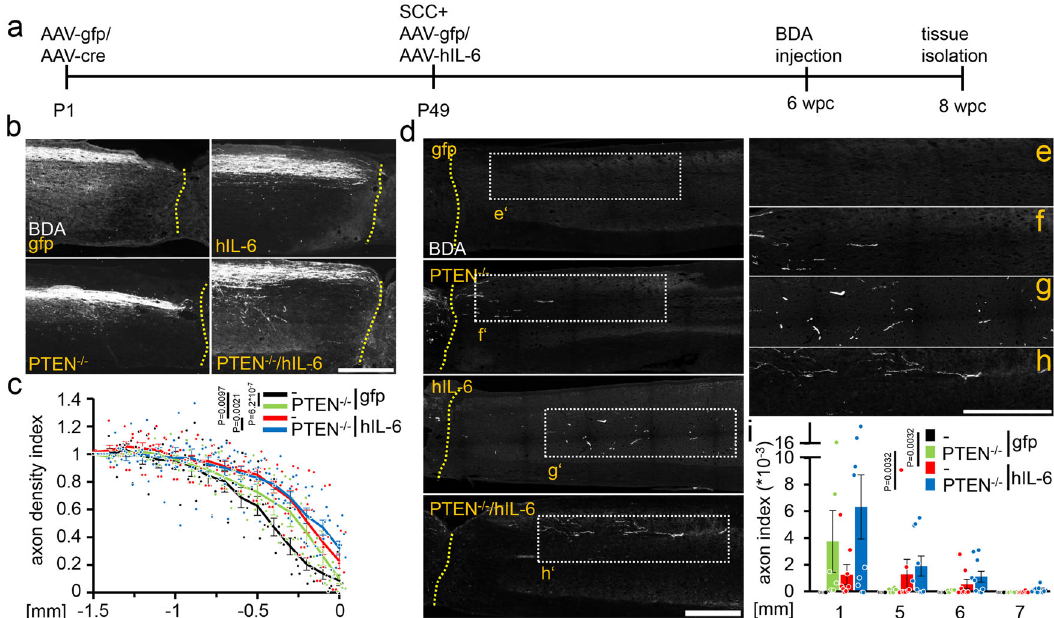
Fig. 2 Hyper-IL-6 promotes CST axon regeneration after severe spinal cord crush. a Timeline of surgical interventions for experiments presented in ( b – i ) and Figs. 3, 4. PTEN f/f mice received unilateral injections of AAV2-GFP (PTEN + / + ) or AAV2-Cre (PTEN − / − ) at P1. After 7 weeks, PTEN + / + and PTEN − / − mice were then subjected to spinal cord crush (SCC) (T8) and subsequently received additional unilateral intracortical injections of either AAV2-hIL-6 (hIL-6) or AAV2-GFP (gfp). b Sagittal thoracic spinal cord sections of four differently treated groups showing BDA-labeled, retracting axons (white) of the right main CST rostral to the lesion site (dotted line). Tissues were isolated 8 weeks after the SCC. Scale bar: 500 µ m. c Axon density index of CST fi bers analyzing all spinal cord sections with the main CST of the animals described in ( a , b ). Values at distances from 1.5 mm rostral to the lesion site ( − 1.5) up to the proximal lesion border (0) were determined. Values represent means ± SEM of 6 – 10 animals per group (PTEN + / + /gfp, n = 7; PTEN + / + /hIL-6, n = 9; PTEN − / − /gfp, n = 6; PTEN − / − /hIL-6, n = 10). d Representative images of BDA-labeled sagittal spinal cord sections from PTEN- fl oxed mice (PTEN f/f ) after treatments, as described in ( a , b ). Tissues were isolated after 8 weeks. BDA-labeled (white) regenerating axons of the central CST beyond the lesion site (dotted line) were seen only after PTEN − / − , hIL-6, or hIL-6/PTEN − / − -treatments. Scale bar: 500 µ m. e – h Higher magni fi cation of regenerating axons in dotted boxes as indicated in ( d ). Scale bar: 500 µ m. i Quanti fi cation of regenerating CST axons at the indicated distances caudal to the lesion site. Axon numbers were divided by the total number of BDA-labeled CST fi bers in the medulla (axon index) from animals as described in ( a , d ). Values represent the mean ± SEM of 6 – 10 animals per group (PTEN + / + /gfp, n = 7; PTEN + / + /hIL-6, n = 9; PTEN − / − /gfp, n = 6; PTEN − / − /hIL-6, n = 10). Signi fi cances of intergroup differences in ( c , i ) were evaluated using a three-way analysis of variance (ANOVA) with Holm Sidak post hoc tests. Statistical signi fi cance is indicated by p -values; ns = non-signi fi cant. Dots in c and i represent values of single animals. Source data are provided as a Source data fi